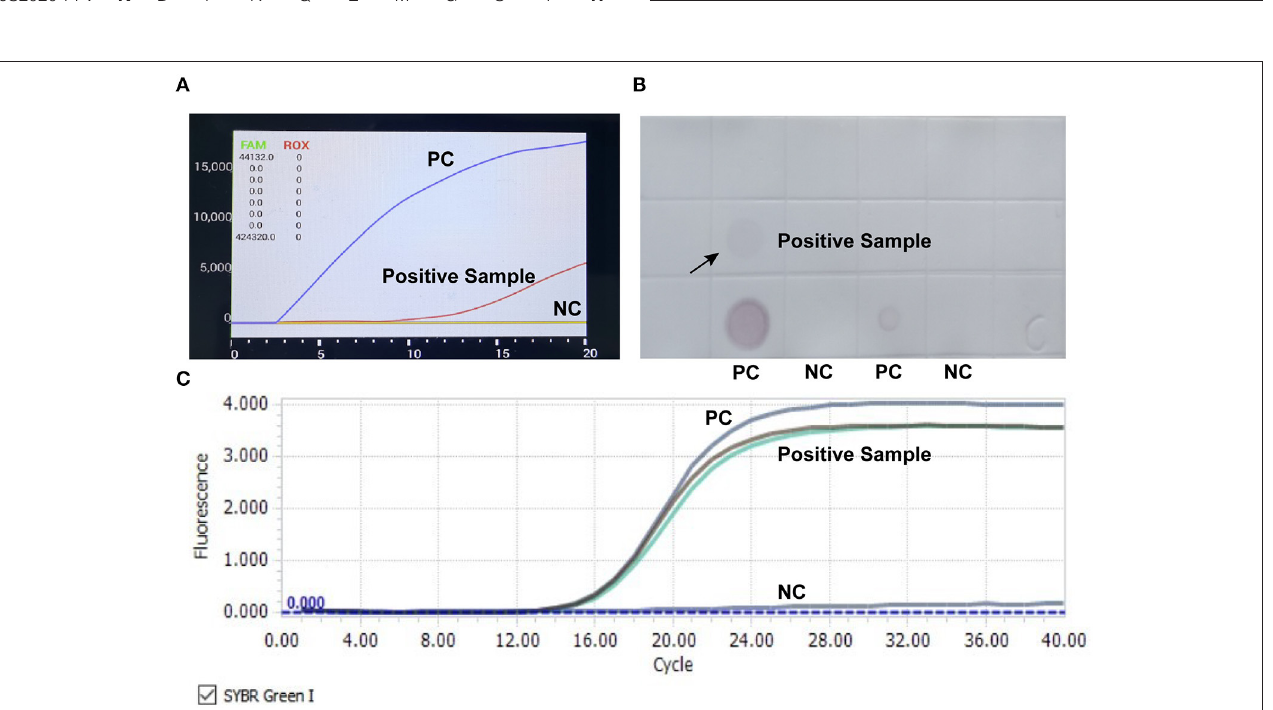
FIGURE 1 | Detection of CIAV nucleic acid in attenuated chicken pox vaccine. RAA rapid assay (A) , nucleic acid dot hybridization (B) , and fluorescence quantitative PCR assay (C) were simultaneously employed to detect CIAV contamination in vaccine samples, and all the methods showed positive results. PC, positive control; NC, negative